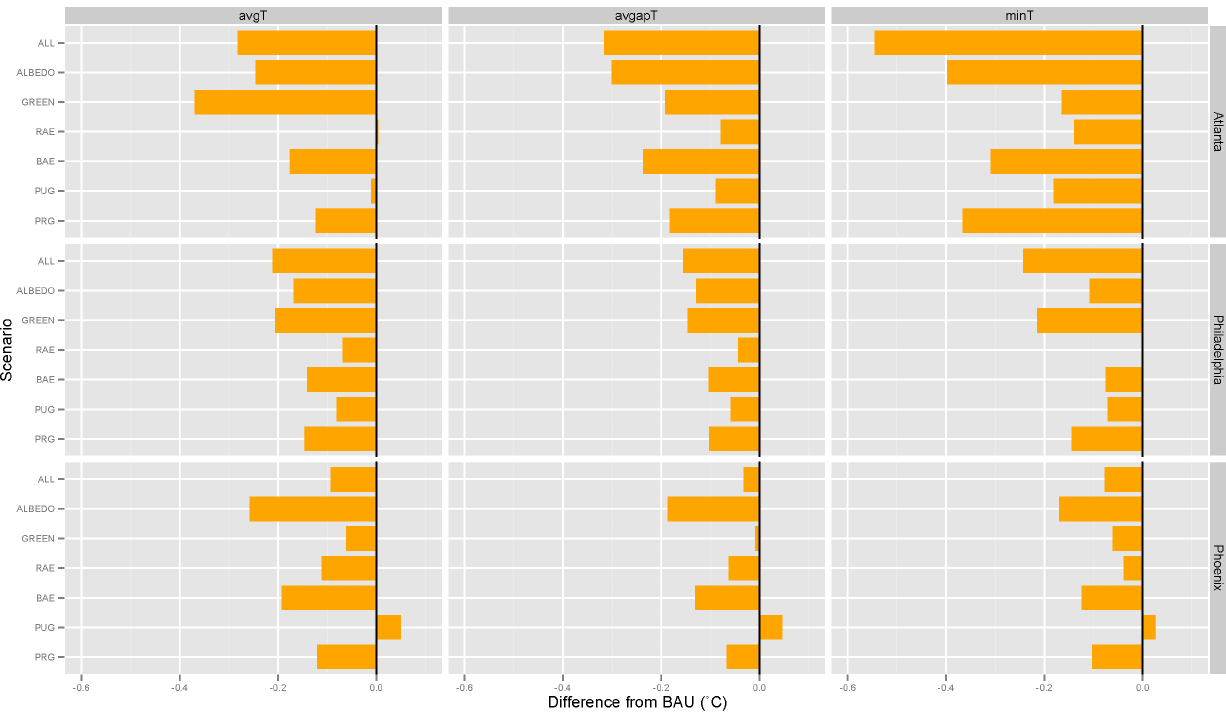
Figure 3. Differences in warm season temperature from BAU by heat management scenario, temperature metric, and MSA.